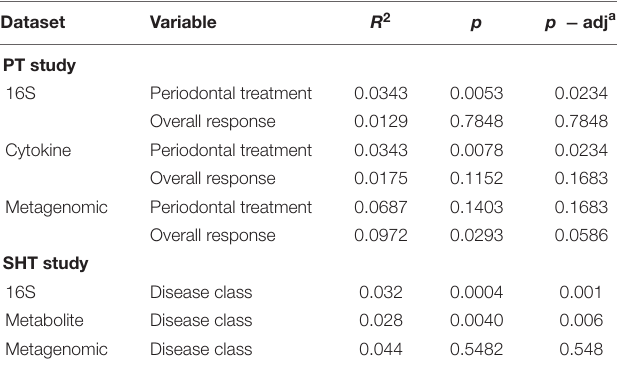
TABLE 1 | PERMANOVA results (9,999 permutations) for centered log-ratio (clr)-transformed periodontal treatment (PT) 16S, cytokine, and metagenomic datasets and sodium hypochlorite (SHT) 16S, metabolite, and metagenomic